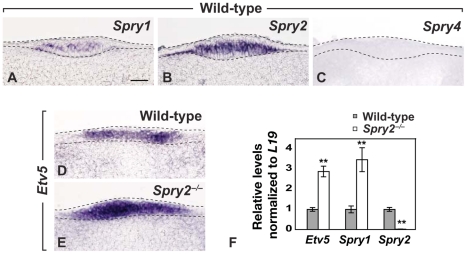

Spry1 and Spry2 are co-expressed in the CV placode and increased FGF signaling is detected in Spry2 mutants.(A–C) Expression of Spry1, Spry2, and Spry4 in the CV placode of wild-type mice. (D,E) Expression of Etv5 in the CV placode of wild-type and Spry2
−/− mice. (F) qPCR analysis of the expression profiles of Etv5 and Sprouty genes in the posterior tongue of wild-type and Spry2
−/− mice at E12.5. Scale bar, 20 µm. **, p<0.001.